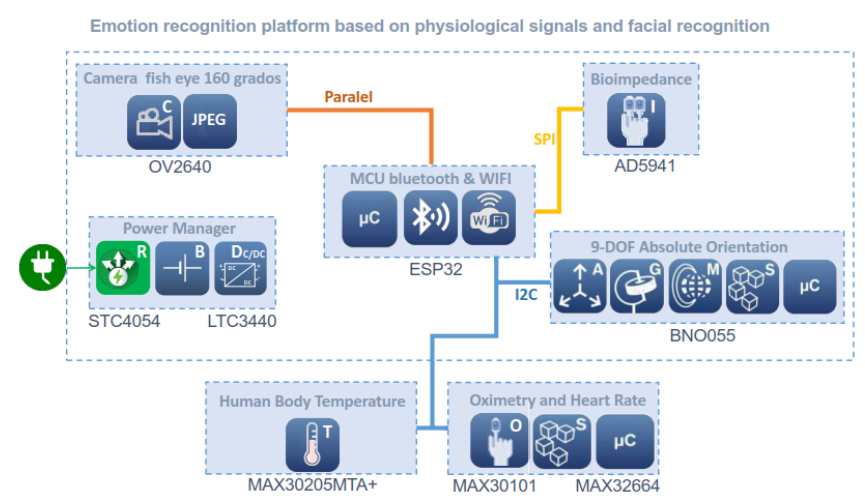
Figure 3. Block diagram of the complete sensoring and processing